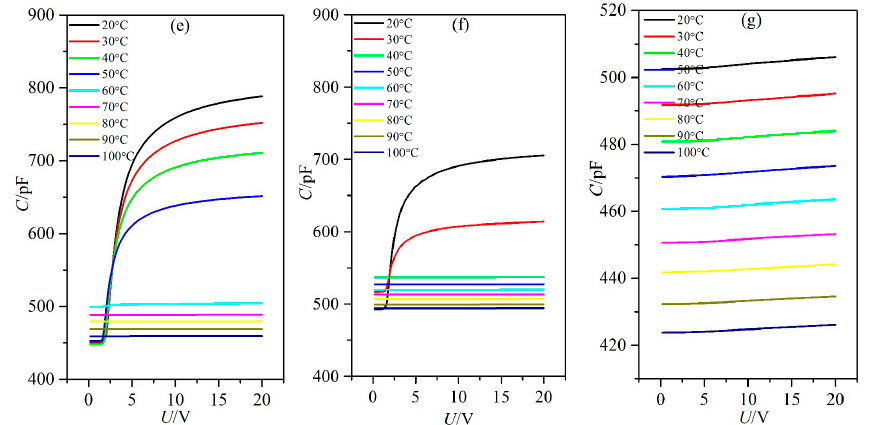
Figure 3. Liquid crystal (LC) cell capacitance versus voltage with frequency of 1 kHz for parallel-aligned nematic (PAN) cell under different temperatures and doped γ -Fe 2 O 3 nanoparticle concentrations of ( a ) 0.0; ( b ) 0.02; ( c ) 0.048; ( d ) 0.145; ( e ) 0.515; ( f ) 0.984; and ( g ) 2.6 wt %.